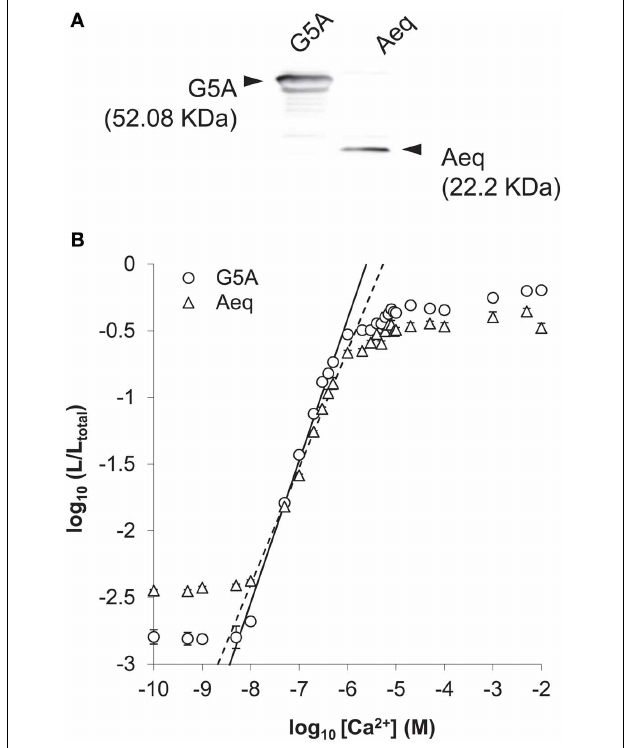
FIGURE 3 | In vitro calibration of G5A and aequorin as Ca 2 + reporters. (A) Immunoblotting of soluble protein fractions from fifty 14 day-old plants of the G5A and Aeq lines with an anti-aequorin polyclonal antibody. Signals of immunoblotting were quantified and indicated as a G5A/aequorin ratio of protein accumulation of 1 . 48 ± 0 . 14 (average of one hundred seedlings obtained in two independent experiments ± SE, n = 2). (B) In vitro calibration curves of G5A and aequorin in soluble protein extracts from G5A and Aeq plants. Equivalent amounts of Ca 2 + reporters were used for the comparison (based on assay reported in A ) and incubated in a buffer containing 2.5 μ M coelenterazine HCP cofactor for 2h in the dark at 4 ◦ C prior light emission assay in the presence of various free Ca 2 + amounts (see Materials and Methods). Results are expressed as the ratio ± SE ( n = 6 in two independent experiments) of maximum light over total light (L/L total ). The linear range of L/L total ratio as a function of free Ca 2 + concentration is shown for G5A (full line) and aequorin (dashed